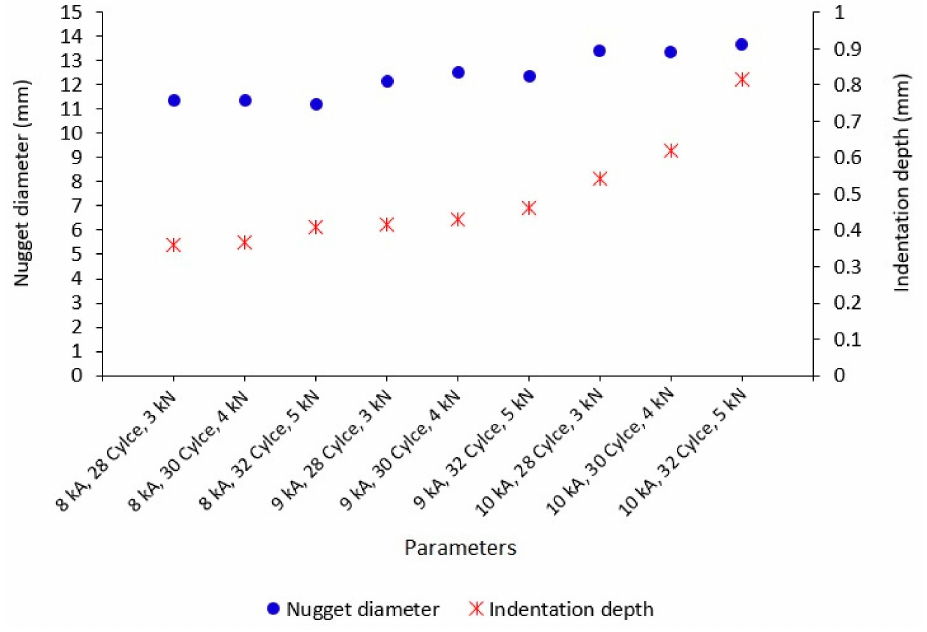
Figure 4. Weld nugget size.